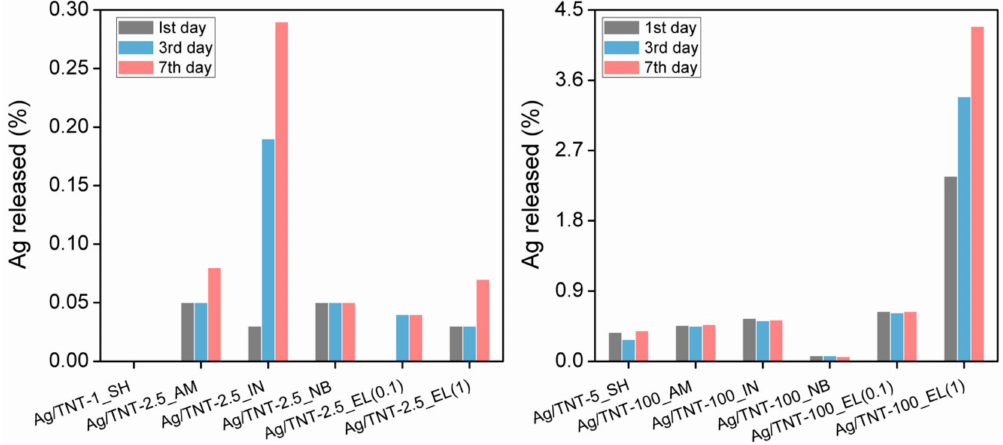
Figure 4. The percentage of Ag + released from di ff erent Ag /